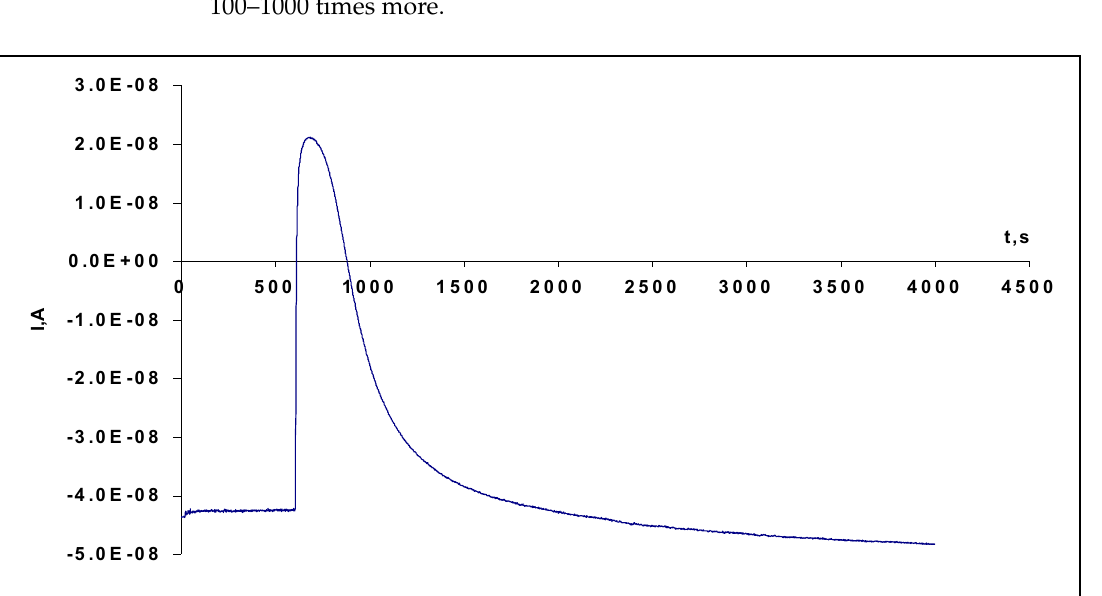
Figure 6. Transmembrane potential as a function of time for impregnated nitrocellulose fi lters with pore size 0.05 µm and 0.45 µm.